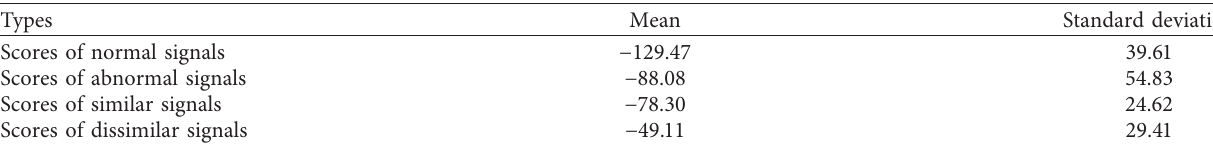
Figure 5: Invert input signals to generate new signals. (a) If the input signal is normal, the generated signal is similar to the input signal. (b) If the input signal is abnormal, the generated signal is dissimilar to the input signal. Table 3: The mean and standard deviation of the